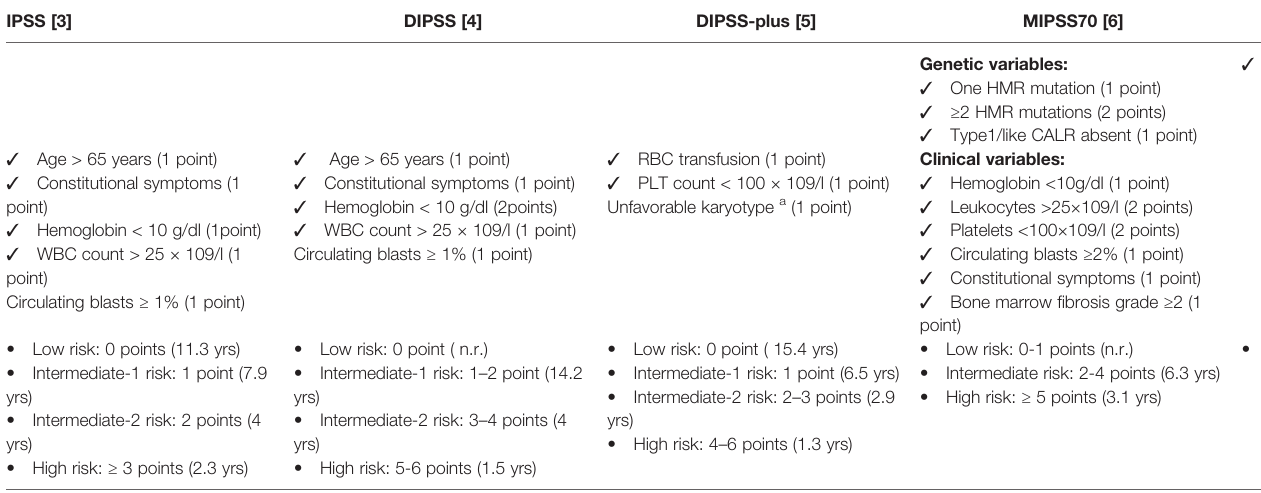
TABLE 1 | Prognostic scoring systems for patients with myelo fi brosis.